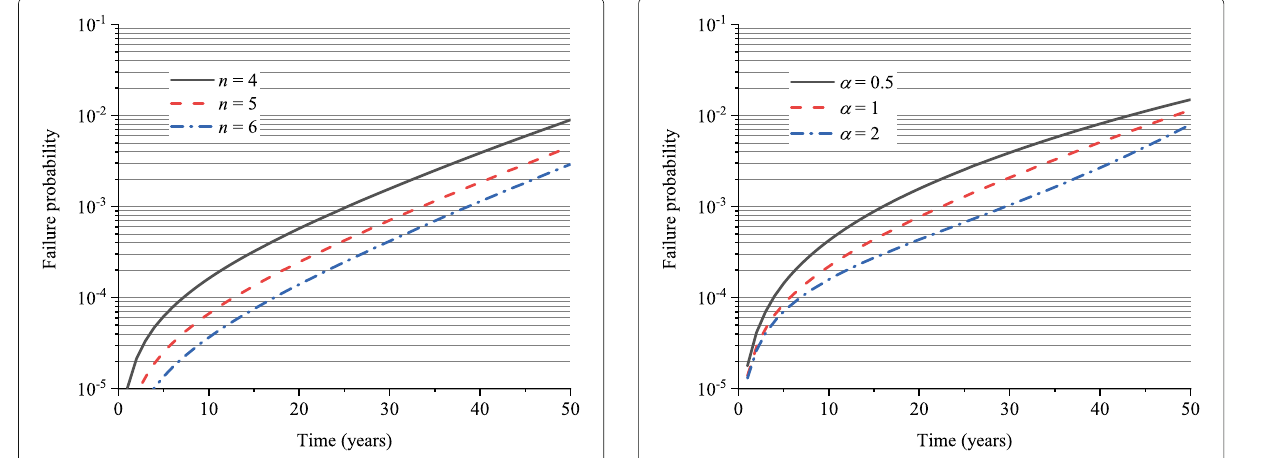
The dependence of system failure probability on the number of components, n , is presented in Fig. 4, where the load model LL2 in Table 1 is used. A greater number of